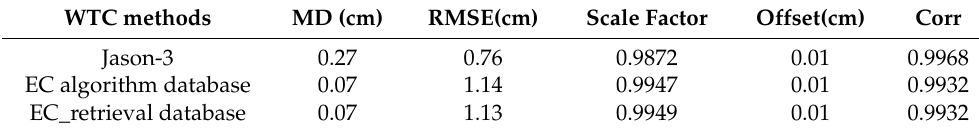
Table 2. Statistical characteristics of comparison between HY-2C WTC and other WTC